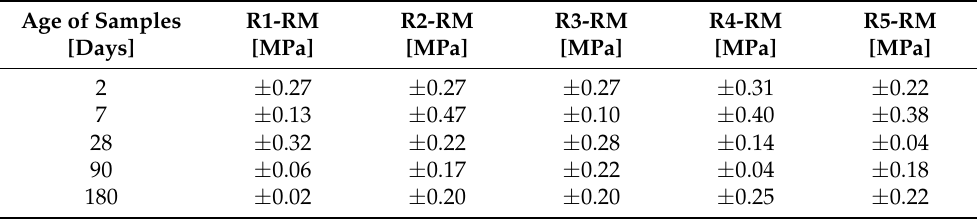
Table 7. Standard deviation values during the measurements of flexural strength